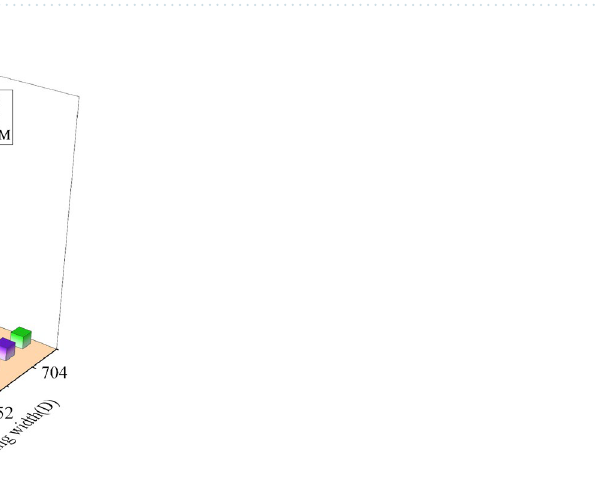
Figure 9. Comparison of the prediction accuracy between different prediction methods.